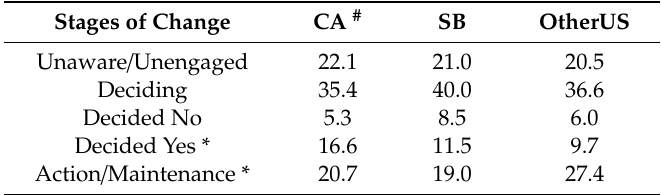
Table 5. Percent of participants in the CA, SB, and OtherUS groups by stage of